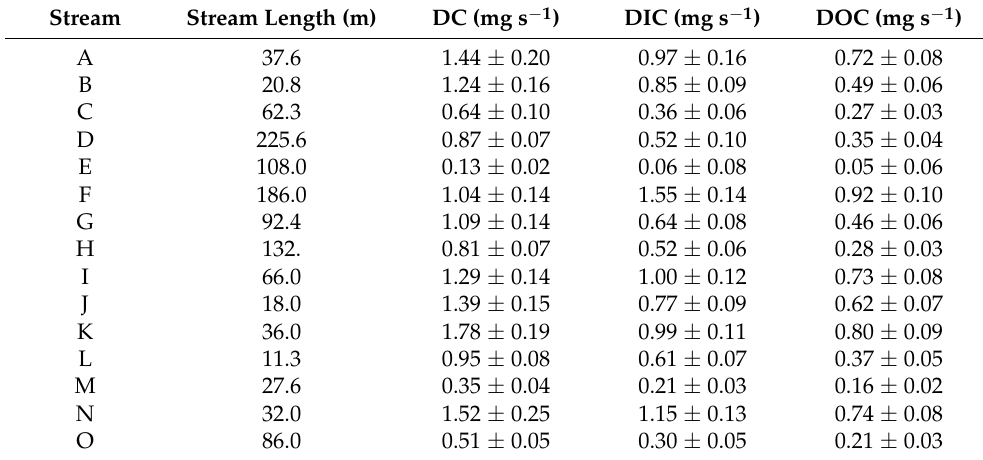
Table 4. Export rates of dissolved carbon (DC), dissolved inorganic carbon (DIC), and dissolved organic carbon (DOC) of the 15 streams in the subalpine forest